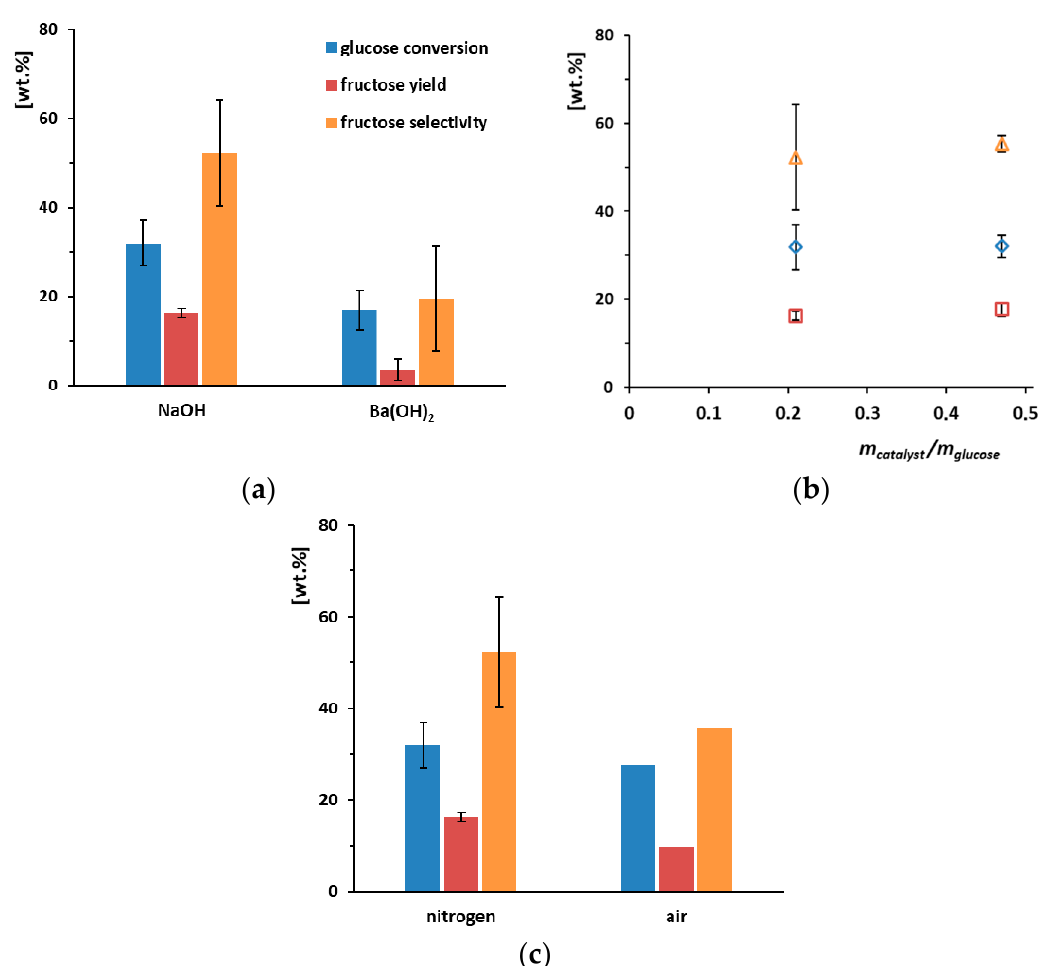
Figure 9. Glucose conversions and fructose yields of the neutralized hydrolysate from lignocellulose with variation of ( a ) the neutralizing agent, ( b ) mass ratio of calcinated hydrotalcite catalyst to glucose, and ( c ) gas atmosphere; pretreatment parameters: spruce wood, T = 200 °C, 0.05 mol/L H 2 SO 4 ; constant isomerization parameters: c glucose = 2.1 g/L, pH ≈ 7, T = 100 °C, t = 40 min; parameters (unless otherwise stated): neutralization with NaOH, nitrogen atmosphere, m catalyst /m glucose = 0.21.